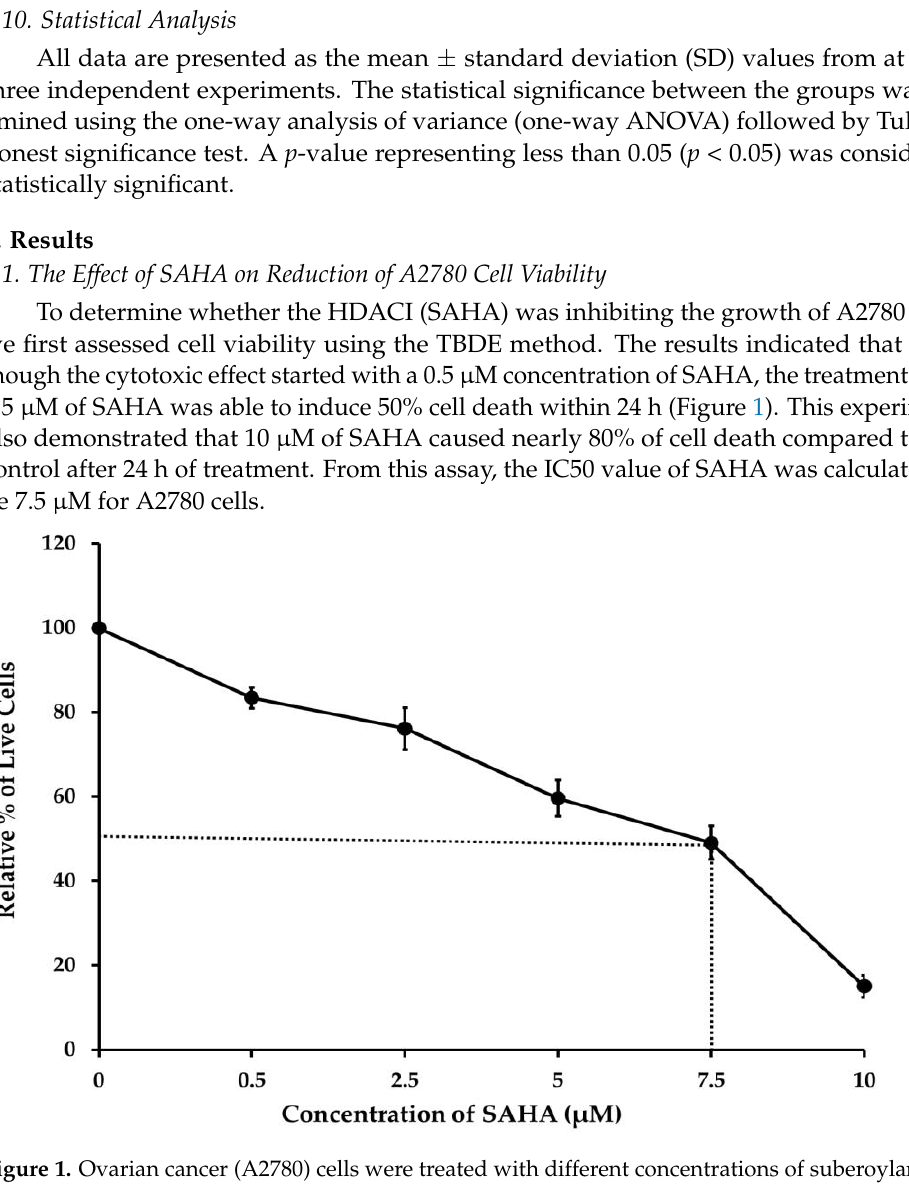
Figure 1. Ovarian cancer (A2780) cells were treated with different concentrations of suberoylanilide hydroxamic acid (SAHA) 0.5 to 10 µM for 24 h. Cell viability was analyzed by the trypan blue dye exclusion (TBDE) method. SAHA decreased the viability of A2780 cancer cells. Data are represented as mean ± SD from three independent experiments.